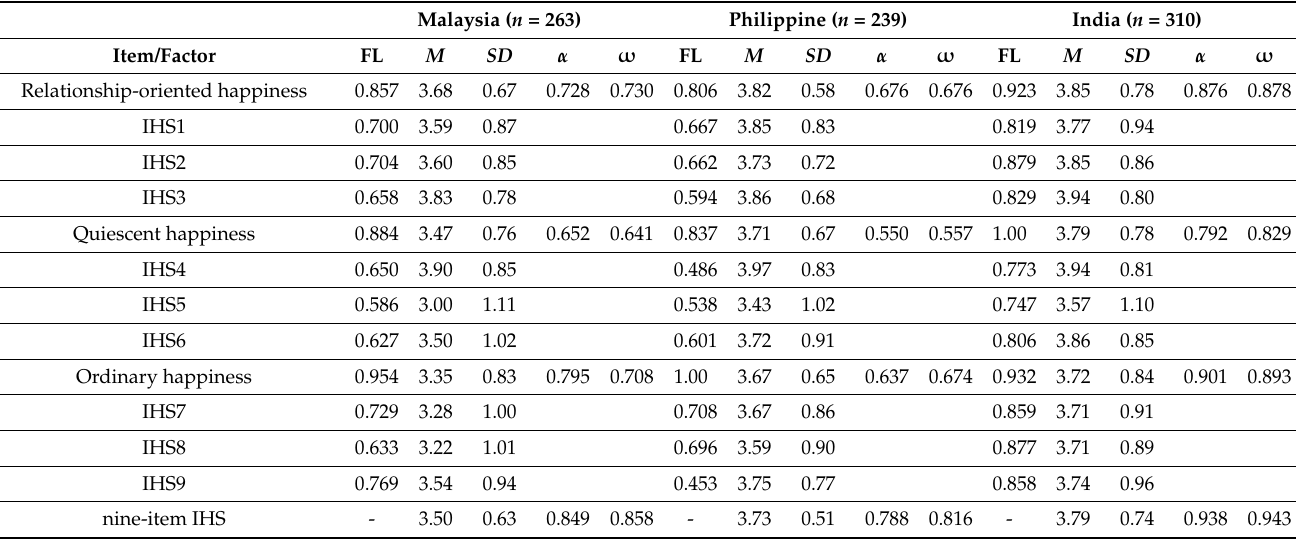
Table 2. Factor loading, descriptive statistics, and reliability of the Interdependent Happiness Scale with nine items. Malaysia ( n = 263) Philippine ( n = 239) India ( n =